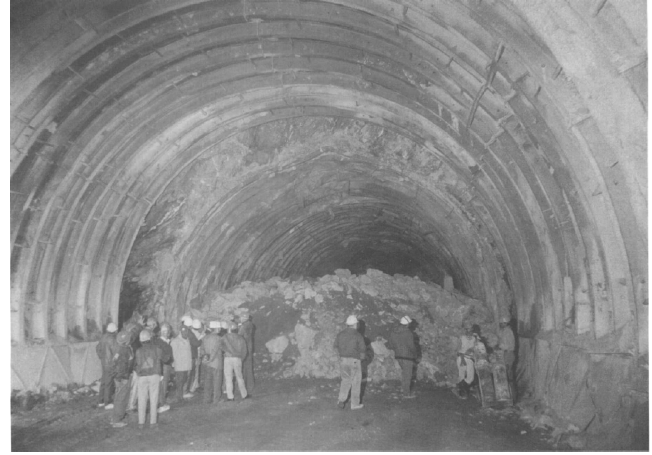
Figure 15. Fallen loose materials and failure of ribs as a result of tunnel convergence in NaJHP (Source: Hoek